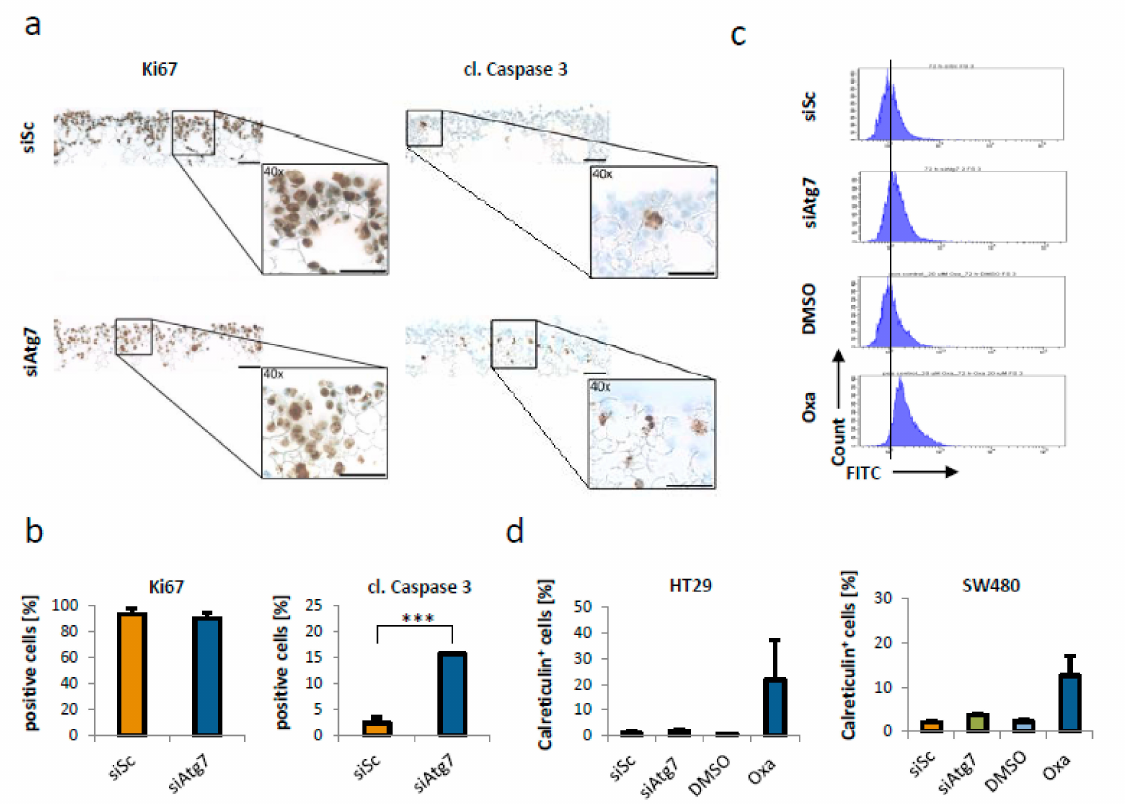
Figure 3. Knockdown of Atg7 did not alter proliferation or immunogenicity of colorectal cancer cells. ( a ) Ki67 (left) and cleaved Caspase 3 (right) staining of siAtg7 (#2; 80 nM) transfected HT29 cells in sca ff olds after 96 h. Scale bars indicate 100 µ m. ( b ) Quantitative analysis corresponding to ( a ). Data represent mean + SD of independent biological triplicates. *** = p < 0.001. ( c–d ) Flow cytometry analysis ( c ) and corresponding quantification ( d ) of the surface expression of calreticulin, showing no increase in HT29 and SW480 cells 48 h after transfection with 80 nM of siAtg7. Treatment with 20 µ M Oxaliplatin (solved in DMSO) for 48 h served as positive control. Data represent mean + SD of independent biological triplicates. X-axis in ( c ) gives logarithmic fluorescence